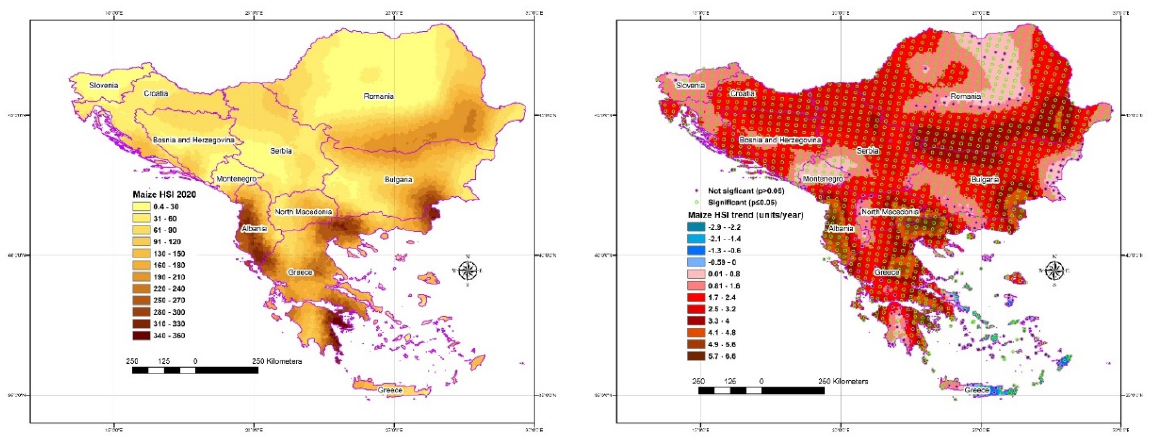
Figure 4. The HSI distribution for the maize cultivation in 2020 ( left ) and the HSI trend with statistical significance marks ( right ).